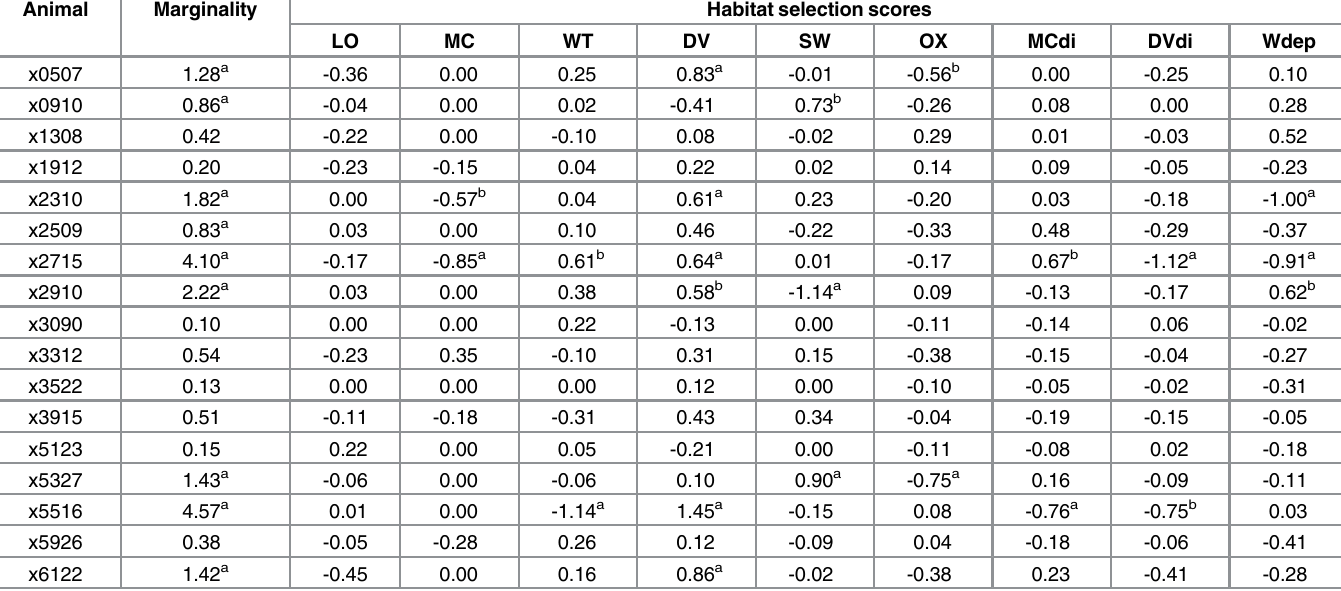
Table 2. Patch selection marginality values of radio-tracked adult male alligators at Ross Barnett Reservoir and Pearl River, Mississippi, USA, 2012 – 2013. Animal Marginality Habitat selection